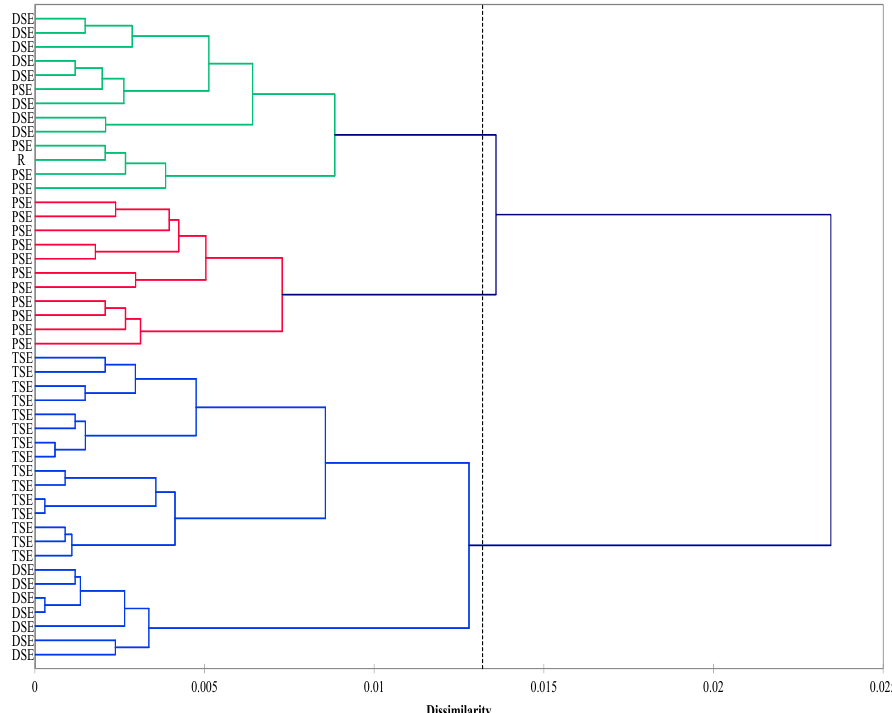
Figure 4. Agglomeration (Ward method; Dice coefficient) analysis of the R, PSE, DSE and TSE sets of regenerates based on AFLP and metAFLP markers. Cluster significance (dotted line) determined on the basis of pseudo-F statistics with significance level p < 0.05 (R—donor plant; PSE—somatic embryos obtained through indirect somatic embryogenesis; DSE—secondary somatic embryos induced on the hypocotyls of PSE; and TSE—somatic embryos obtained through direct somatic embryogenesis from DSE).